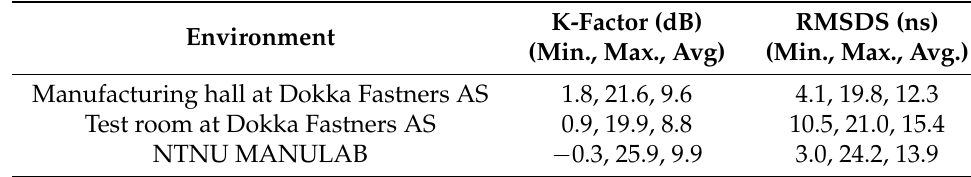
Table 5. K-factor and RMSD at all measurement locations.